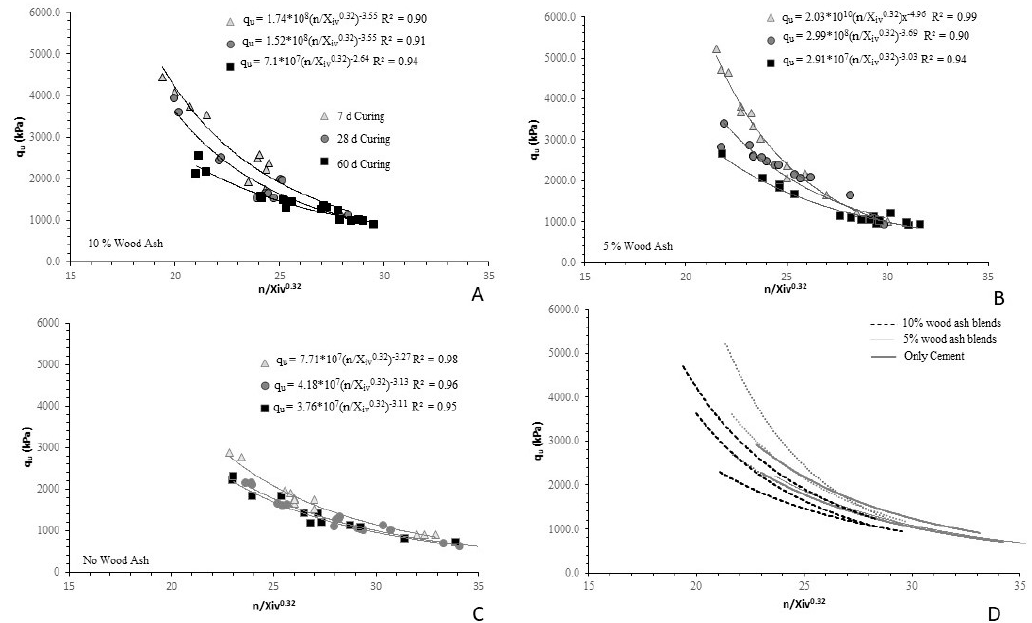
Figure 4. Variation of unconfined compressive strength (q u ) with adjusted porosity / binder index for ( A ) compacted marine clay + cement + 10% wood-ash blends, ( B ) compacted marine clay + cement + 5% wood-ash, ( C ) compacted marine clay + cement blends, ( D ) regression curves of all blends at 7, 28, and 60 days of curing.